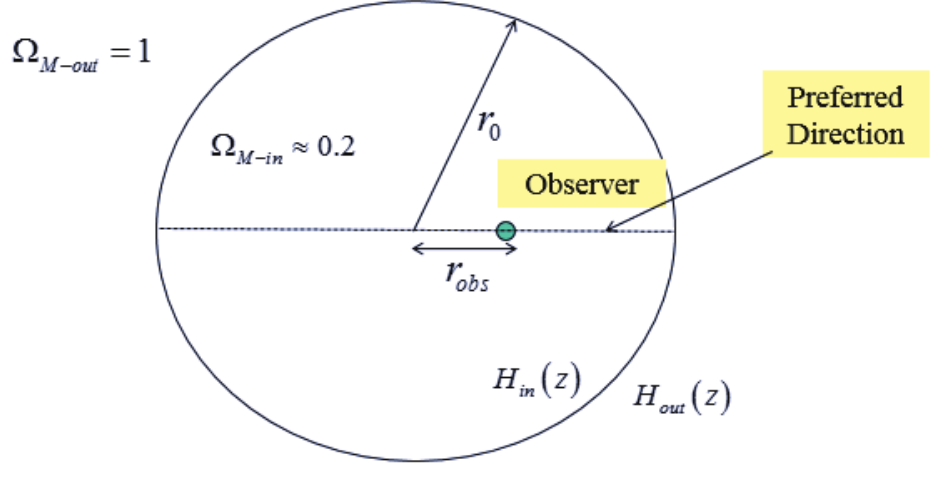
Figure 3. An off-center observer in a spherical inhomogeneity sees a preferred direction of higher accelerating expansion